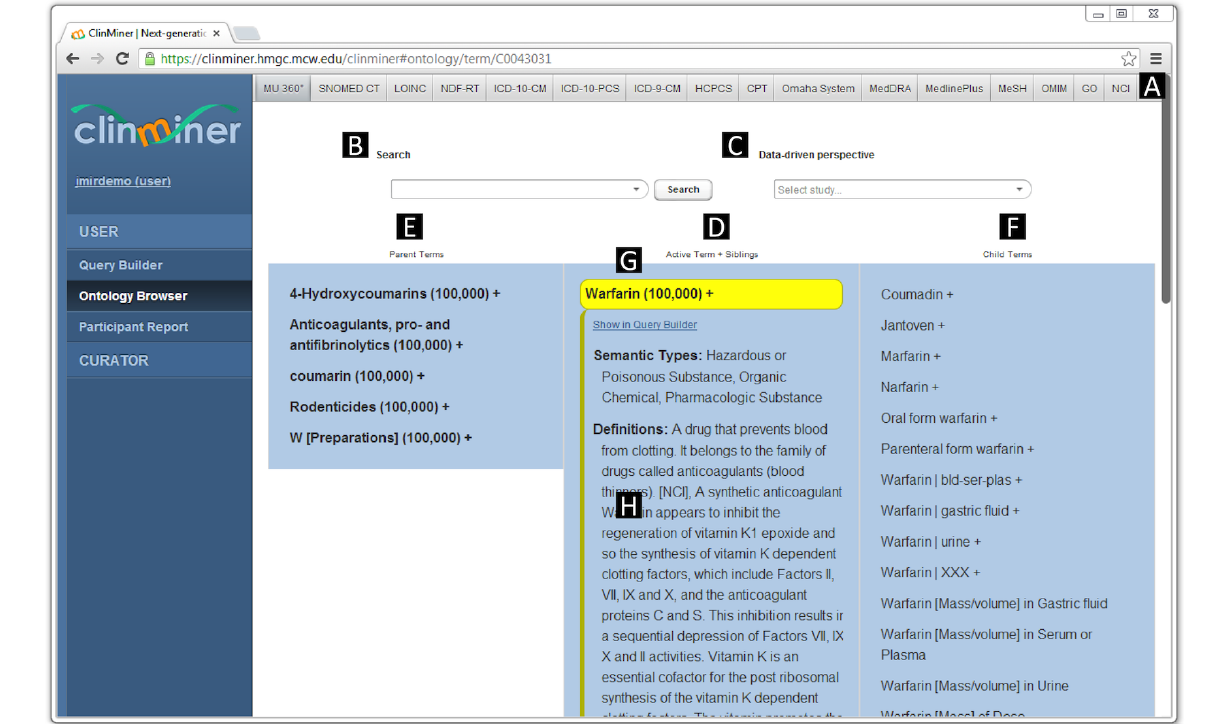
Figure 1. Screenshot of ClinMiner’s integrated terminology browser. The tabs allow switching between different terminologies and the integrated MU 360 view, default choice (A). Searching. Typing a query into the input field (B) brings up autosuggestions. Selecting a particular string populates the middle panel (D) with search results. Selecting a search result brings back the hierarchical view with the selected term (Warfarin) highlighted in yellow (G). Browsing. Parents of the active term are displayed in the left pane and child terms are displayed in the right pane (F). Meta data for the active term including semantic types, definitions, and non-isa relations to other concepts are displayed in a vignette directly below (H). A plus sign (+) after the term label denotes concepts with children, and the number in brackets reflects the number of participants annotated to a particular term (or its children) in the database. Selecting a study from the drop-down list (C) enables the data driven perspective that displays a compact terminology tree limited to only relevant